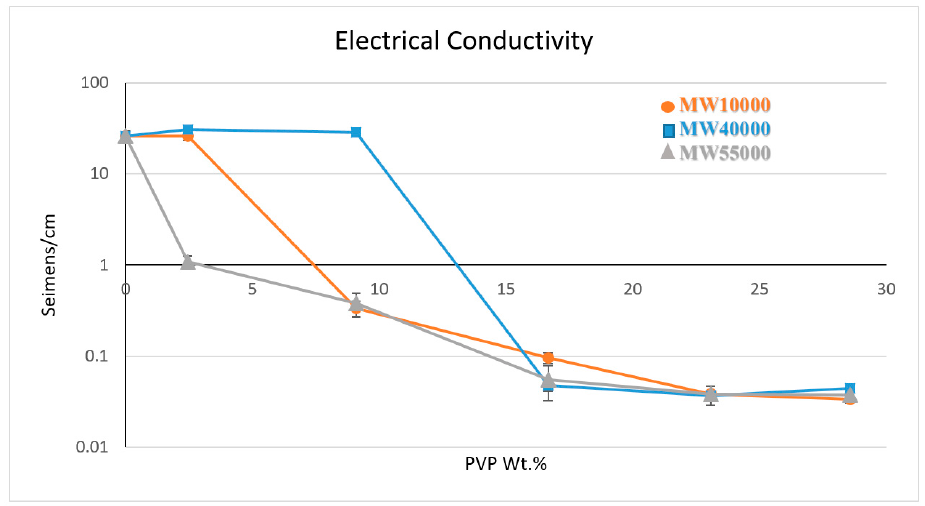
Figure 4. Electrical conductivity measure of three different PVP functionalised MWNT/PVDF composites.